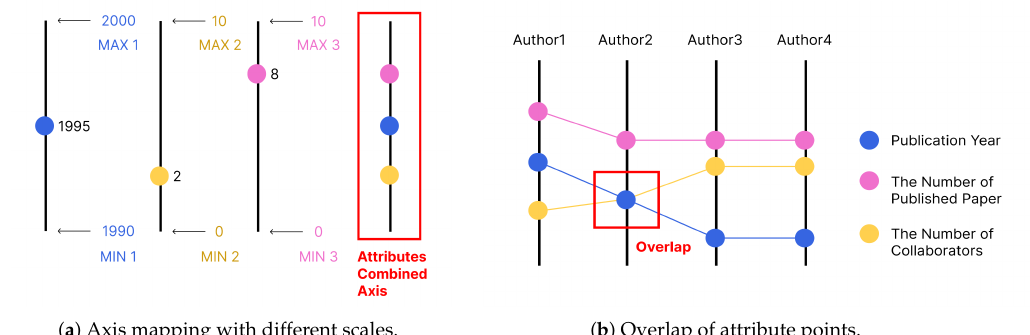
Figure 2. Visual mapping of